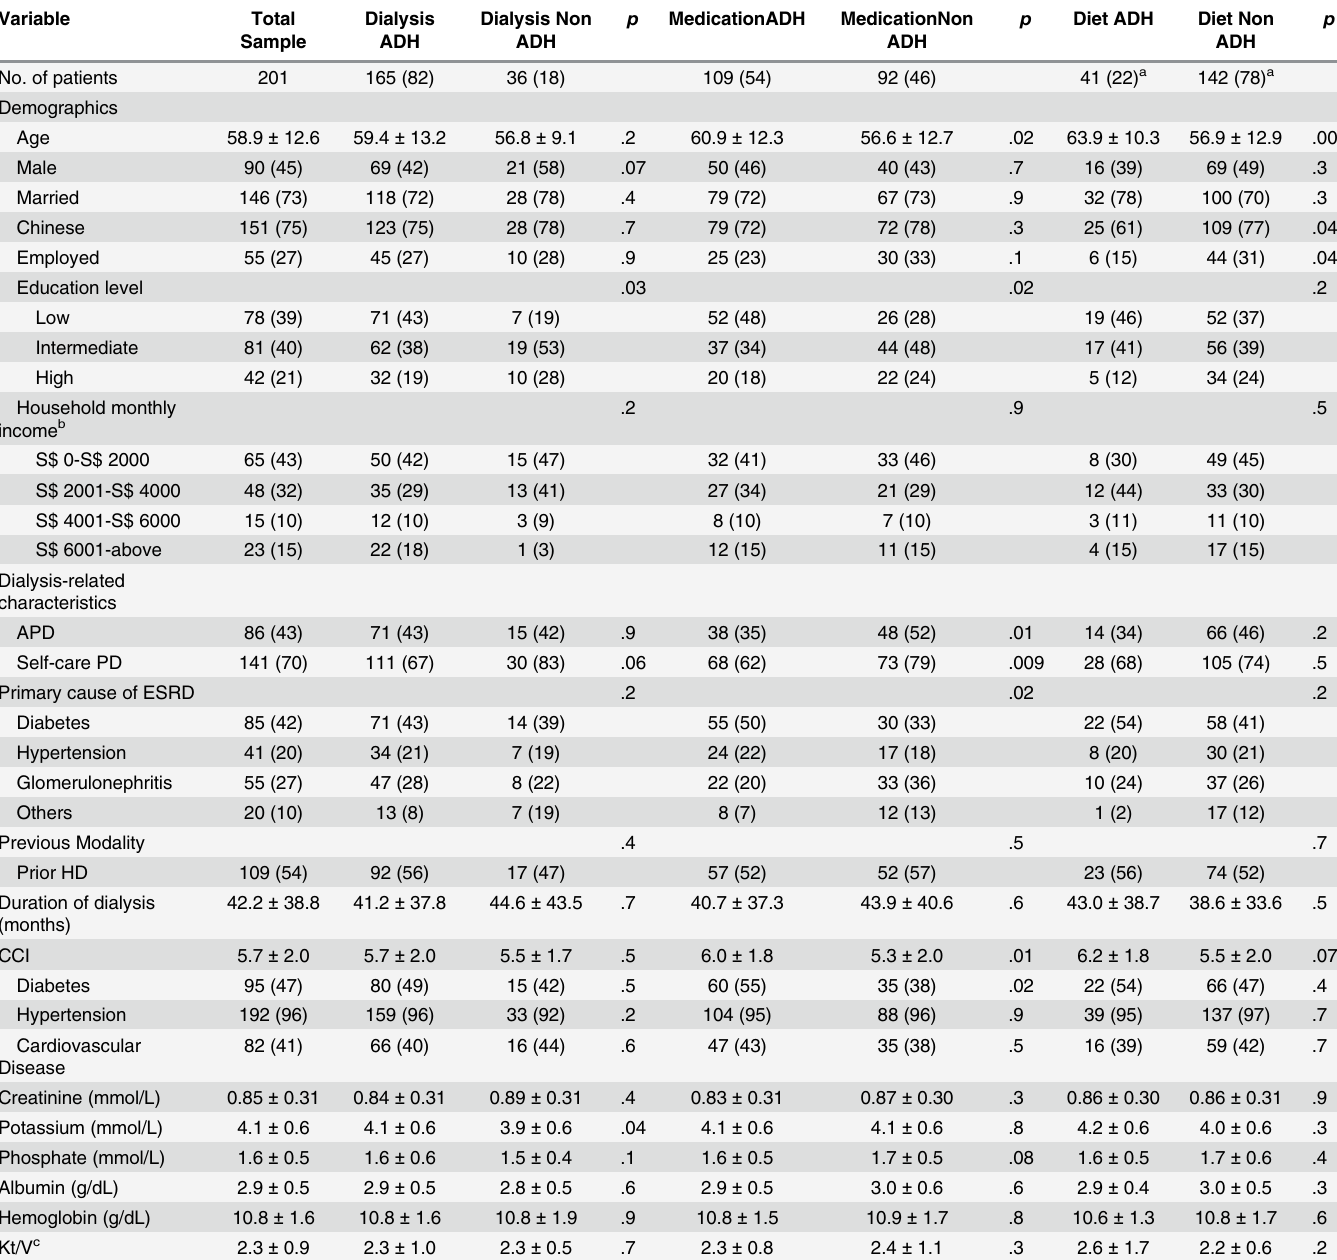
Table 1. Sociodemographic and clinical characteristics for total sample and as stratified by adherence status on diet, medication and